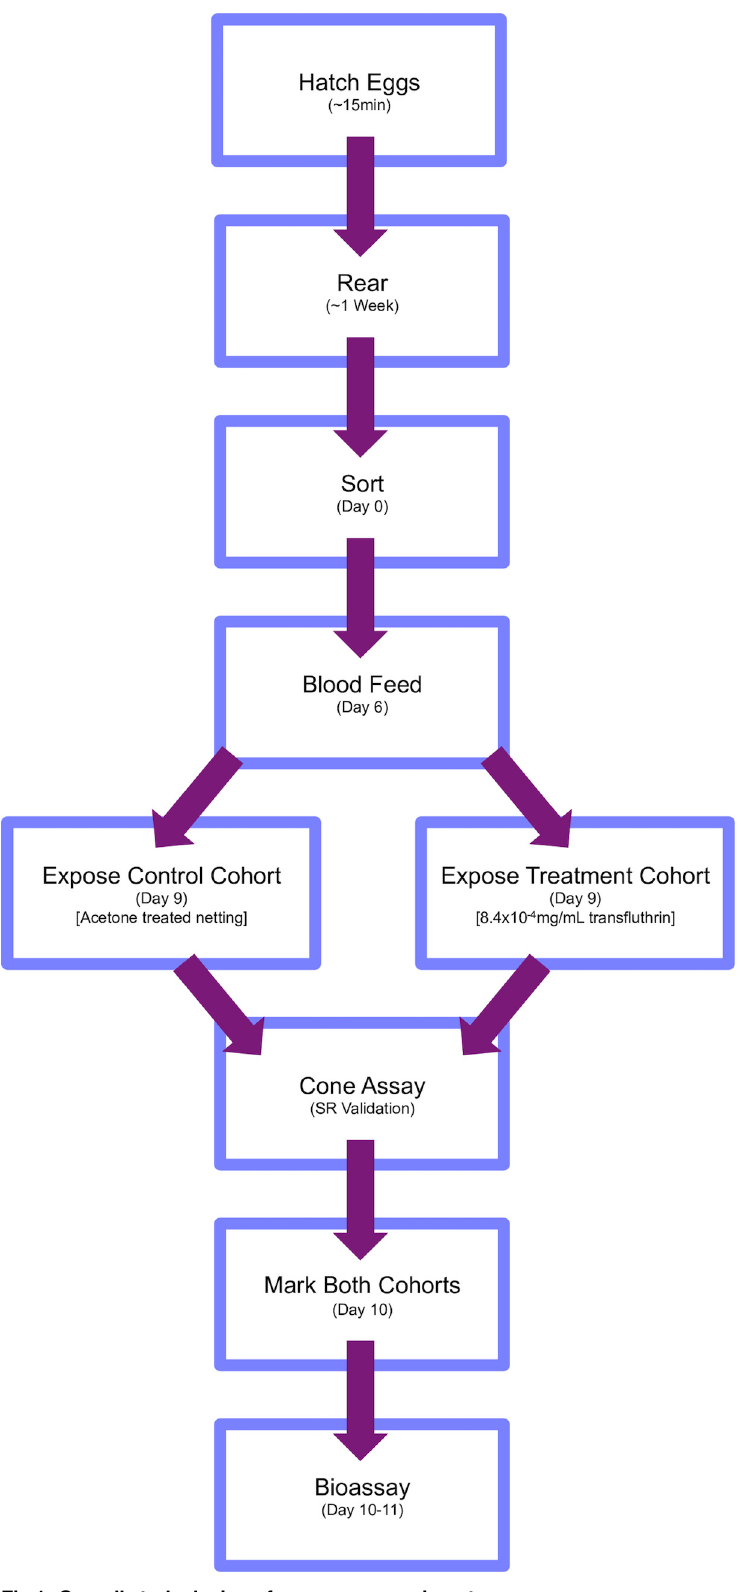
Fig 1. Overall study design of exposure experiments.